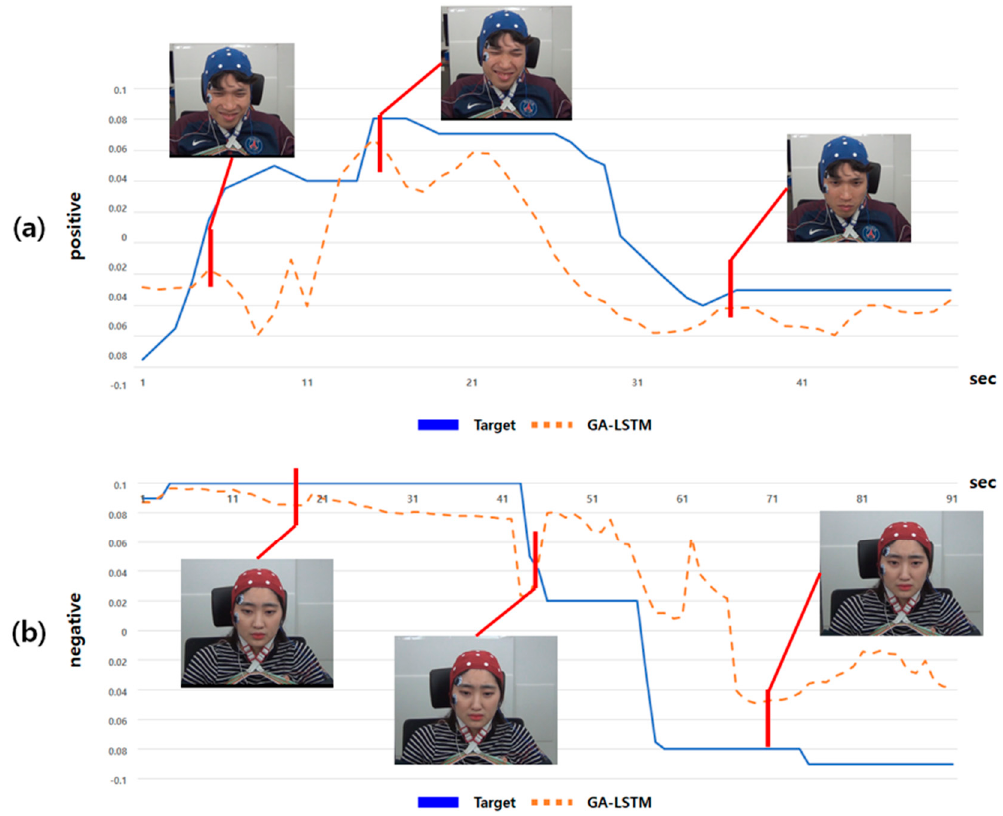
Figure 9. Example of MERTI-Apps test result. ( a ) Positive valence, ( b ) negative valence.